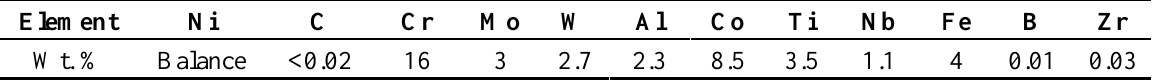
Table 1. Chemical composition (in wt. %) of AD730™ nickel-based superalloy.